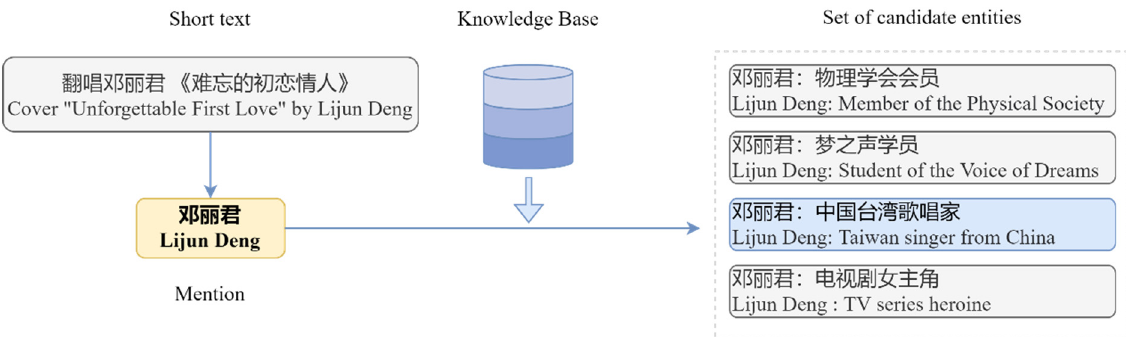
Figure 1. Example of generating a candidate entity set.